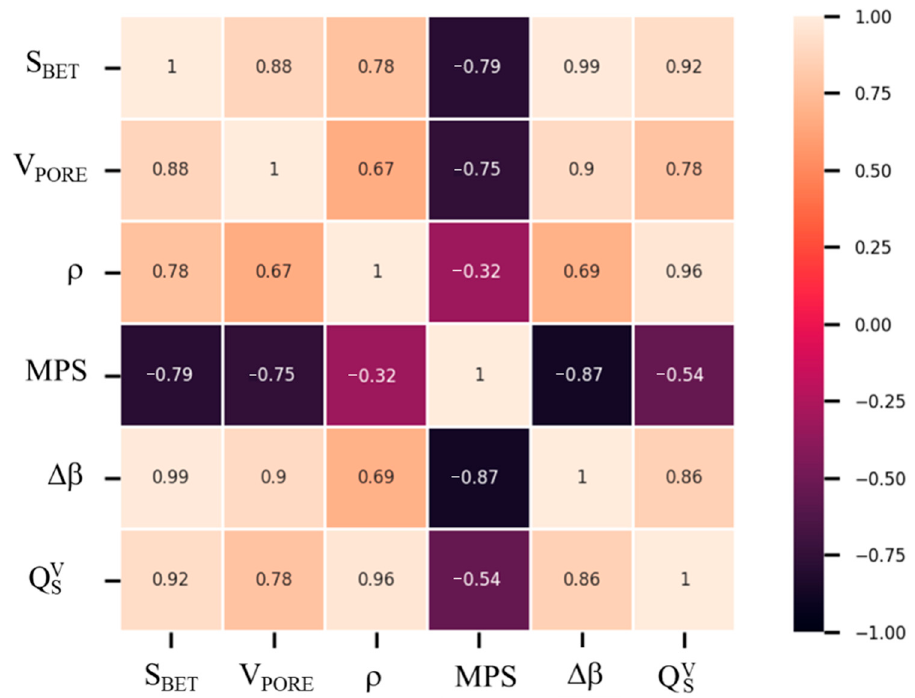
Figure 10. Correlation matrix of samples’ physical, morphological and thermochemical character- istics.